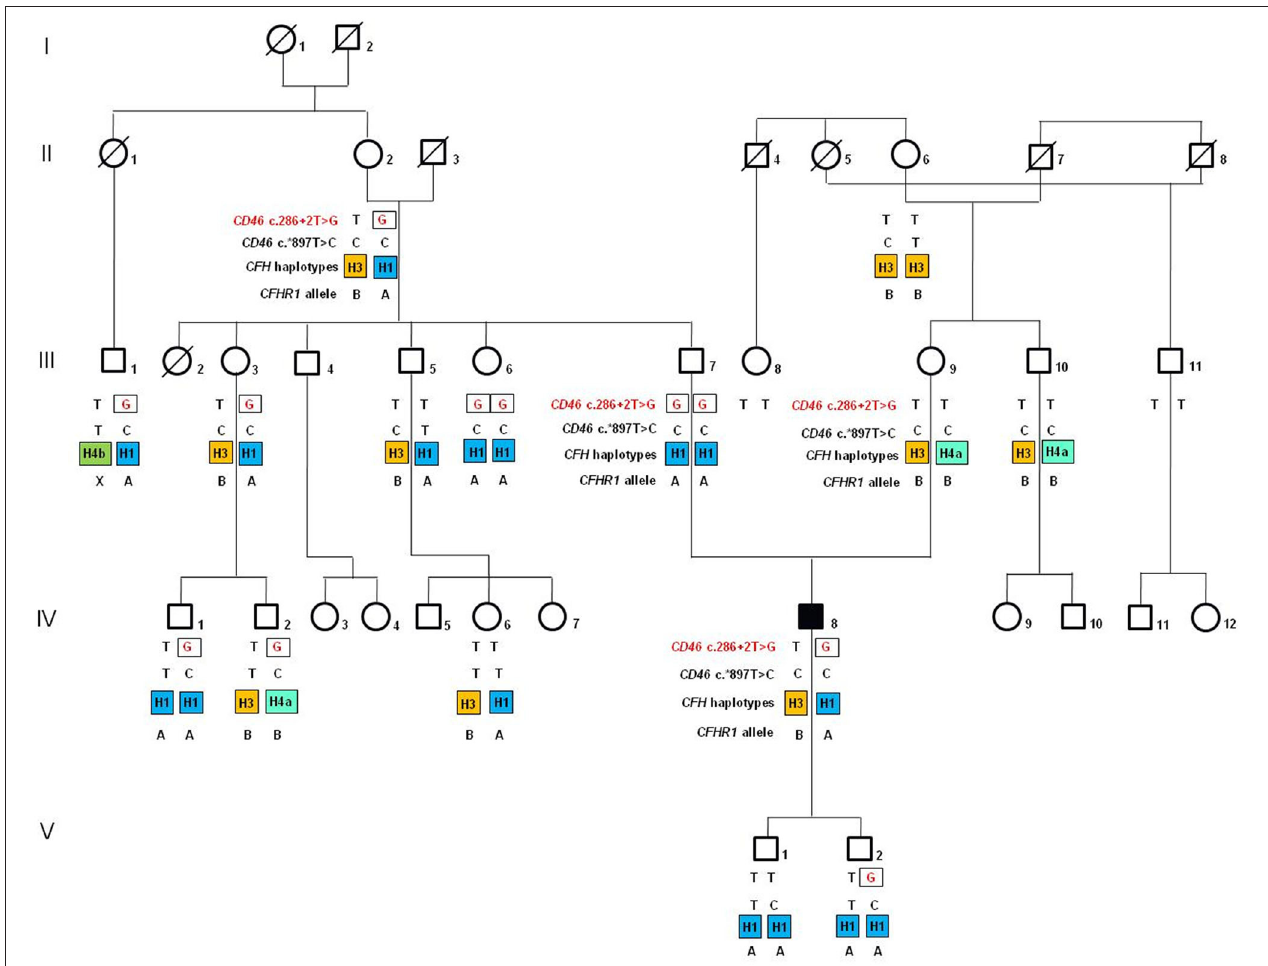
FIGURE 1 | Pedigree (#646) of the atypical hemolytic uremic syndrome (aHUS) patient (IV-8; indicated by the black square) carrying the heterozygous c.286 + 2T > G rare variant (rs769742294) in the gene encoding membrane cofactor protein ( CD46 ). The CD46 c.286 + 2G rare variant is indicated in red. The CD46 c.*897T > C SNP (rs7144) tags the risk CD46 GGAAC haplotype. In orange is indicated the disease risk haplotype CFH TGTGGT ( CFH–H3 haplotype), while in blue and in green are indicated CFH haplotypes ( CFH CGGAGG or CFH-H1 ; CFH CGTAAG or CFH-H4a ; CFH TGTAAG or CFH-H4b ) not associated with aHUS. A indicates the CFHR1 * A allele, which encode the acid (A) isoform of FHR1, and B indicates the CFHR1 * B allele that is a risk factor for aHUS when present in homozygosity and encodes the basic (B) isoform of FHR1.